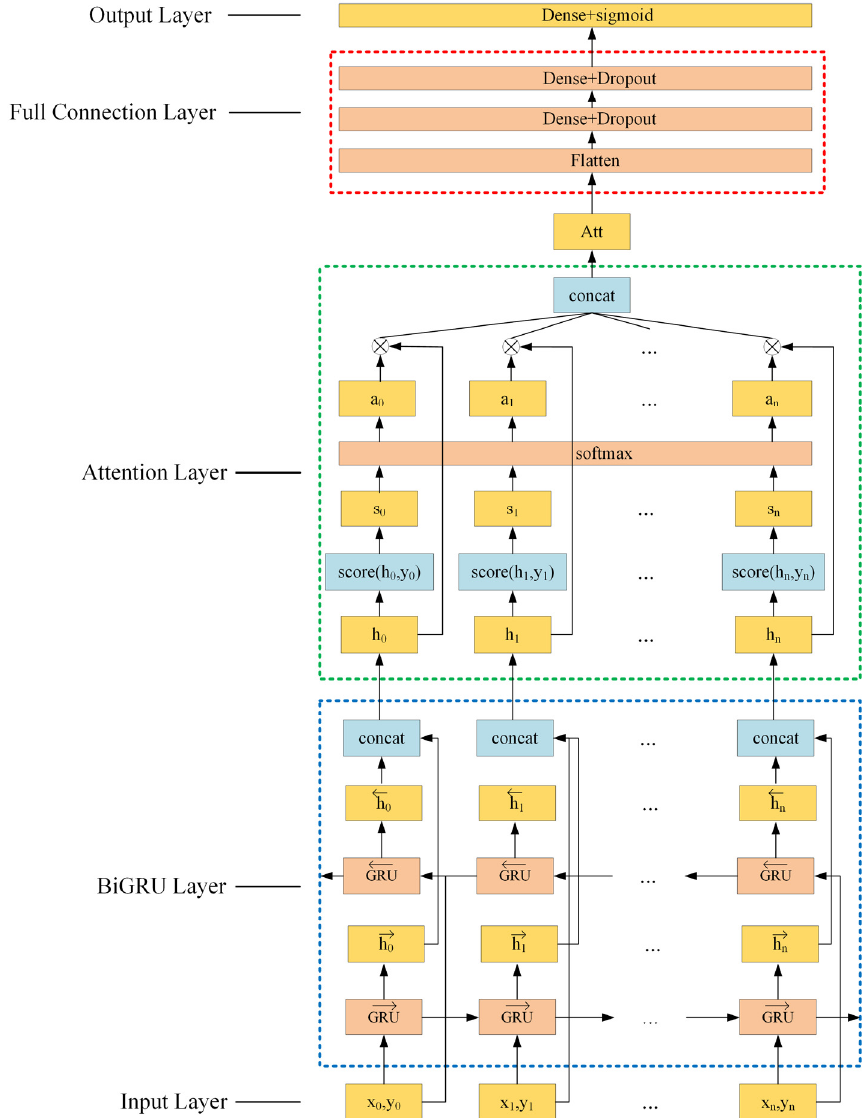
Figure 7. Schematic diagram of the proposed Attentional BiGRU.